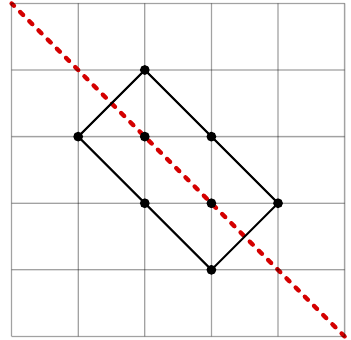
Figure 17. An example of a rectangle toric diagram with its diagonal axis of